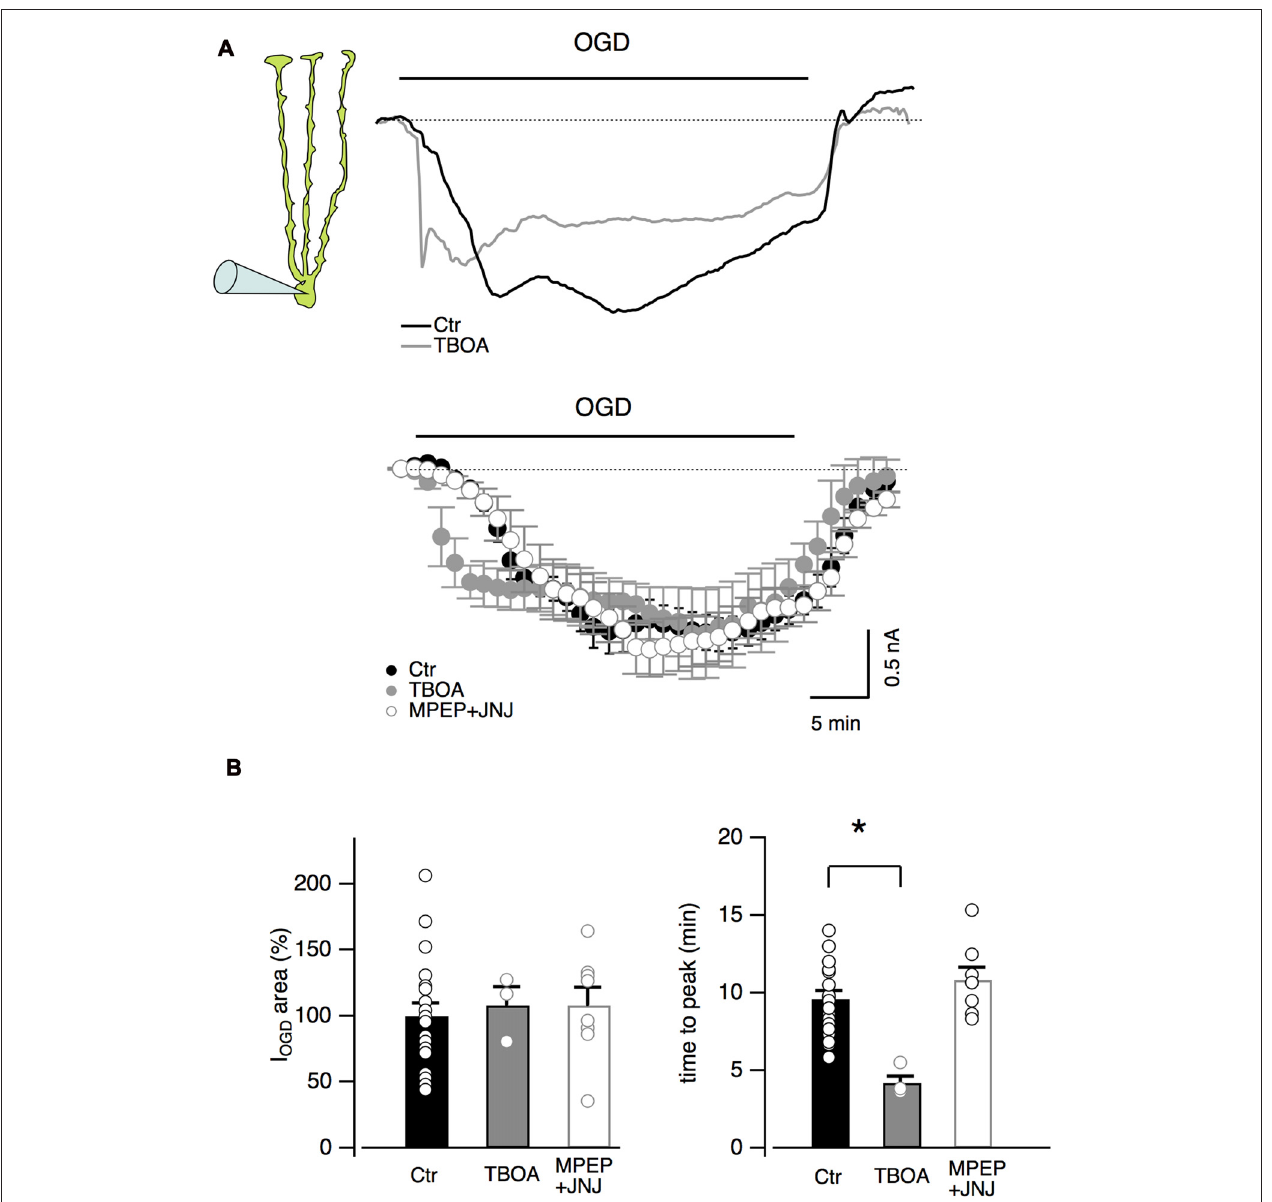
FIGURE 4 | Inhibition of glutamate transporters accelerates OGD kinetics in Bergmann glia. (A) Top: examples of Bergmann glia currents in control and in the presence of TBOA (100 µ M), an inhibitor of glutamate transporters. Bottom: mean traces in control ( n = 19), in presence of TBOA ( n = 4) or with group I